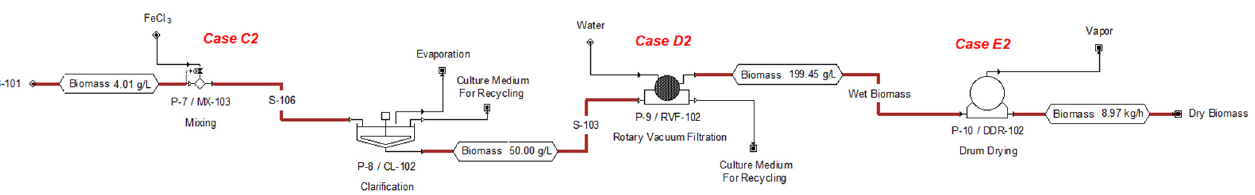
Appl. Sci. 2021 , 11 , x FOR PEER REVIEW 10 of 25 Figure 4. Flowsheet for the harvesting section (primary and secondary) and drying stage, of scenario 12 (case C, D and E).